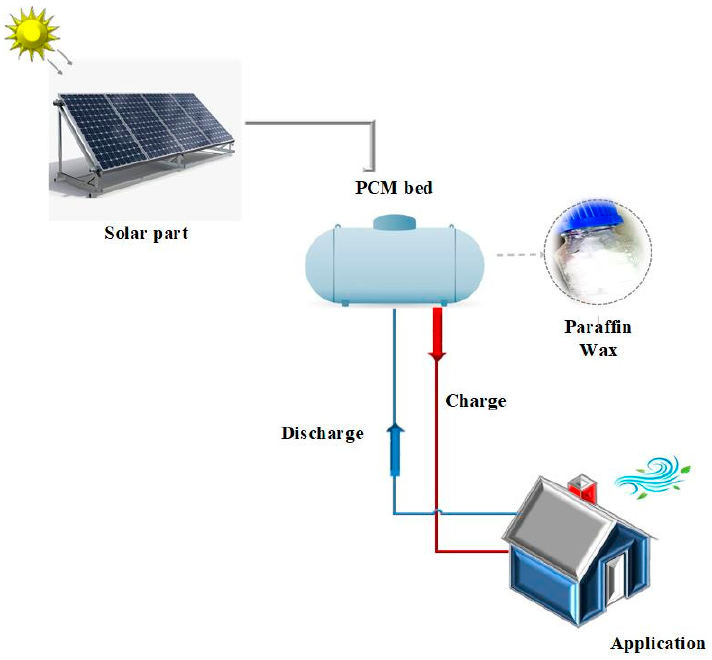
Figure 7. Design of conventional tank storage system in a concentrating solar system used in this study.